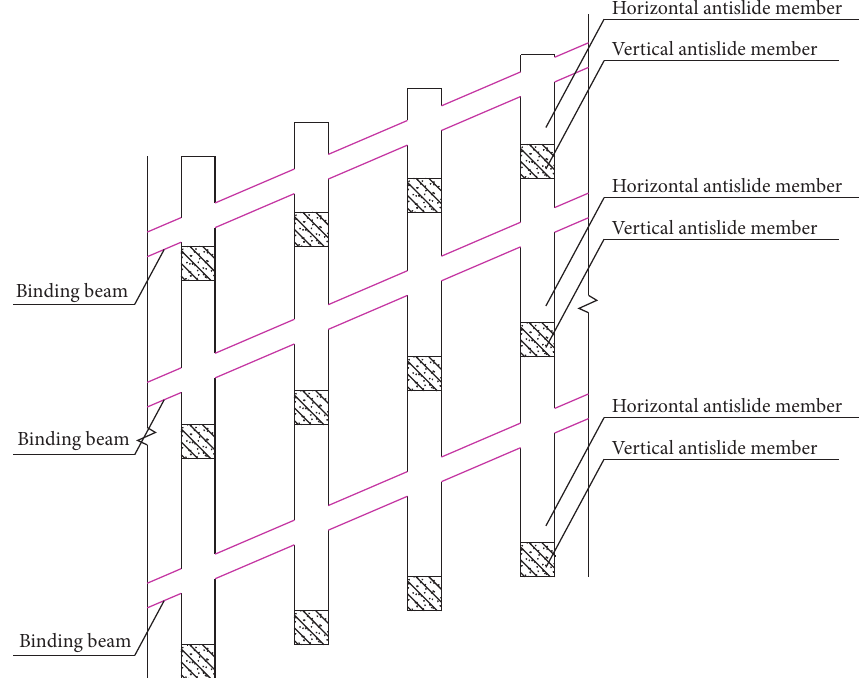
Figure 2: The plane layout of an ASCL. ASCLs are constructed along the longitudinal direction. Binding beams connect the ASCLs along the horizontal